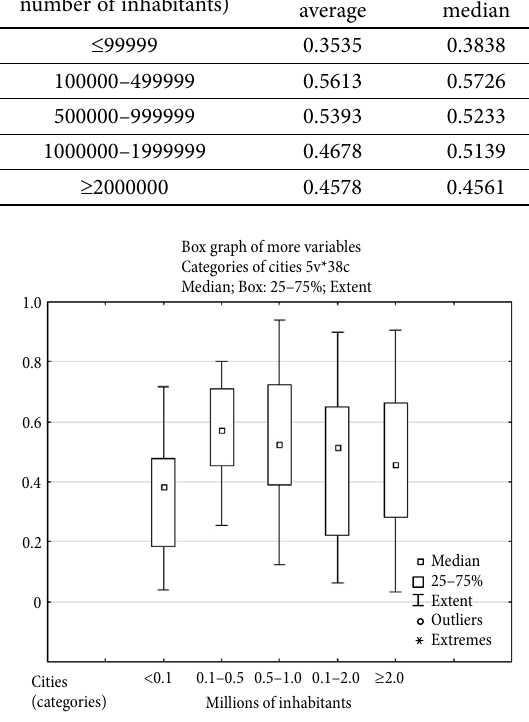
Fig. 4. Scores of UPT websites after size of cities